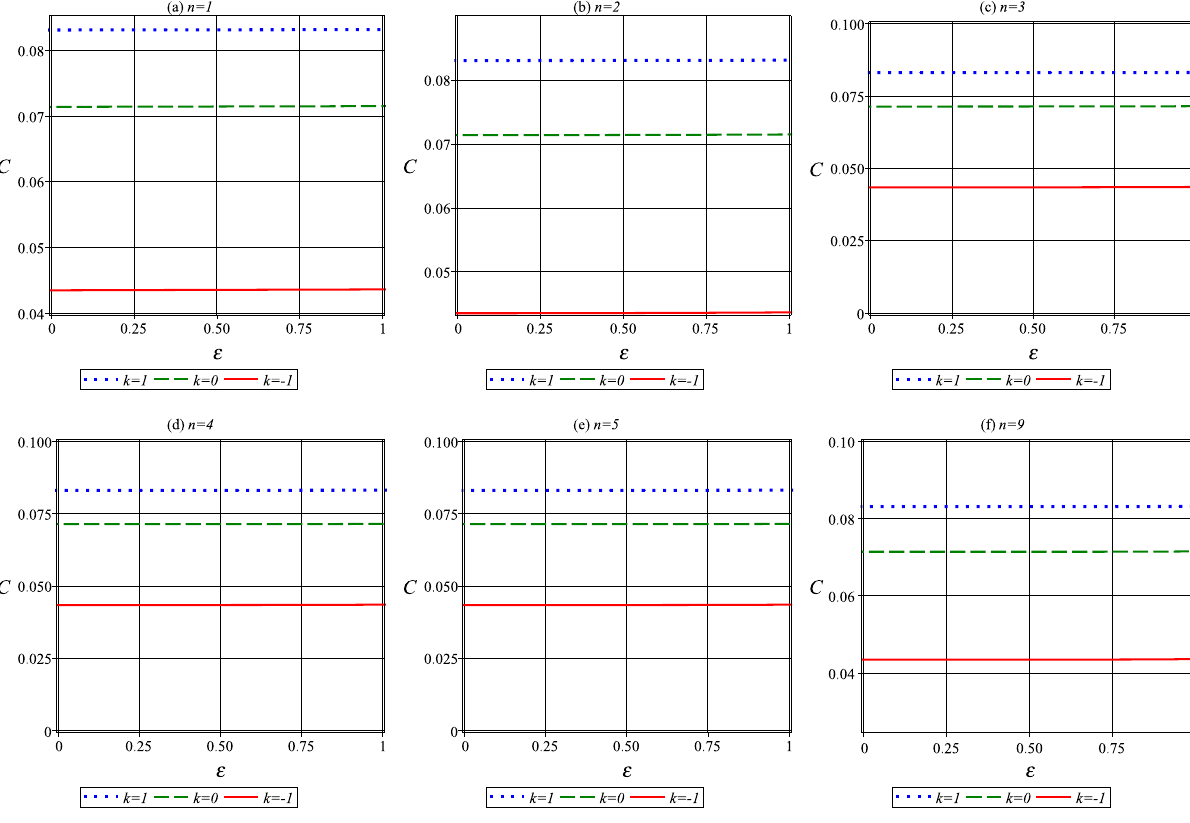
Fig. 5 Specific heat of the first model (Eq. (3.9)) in terms of ε for η = 0 . 001, and unit value for other